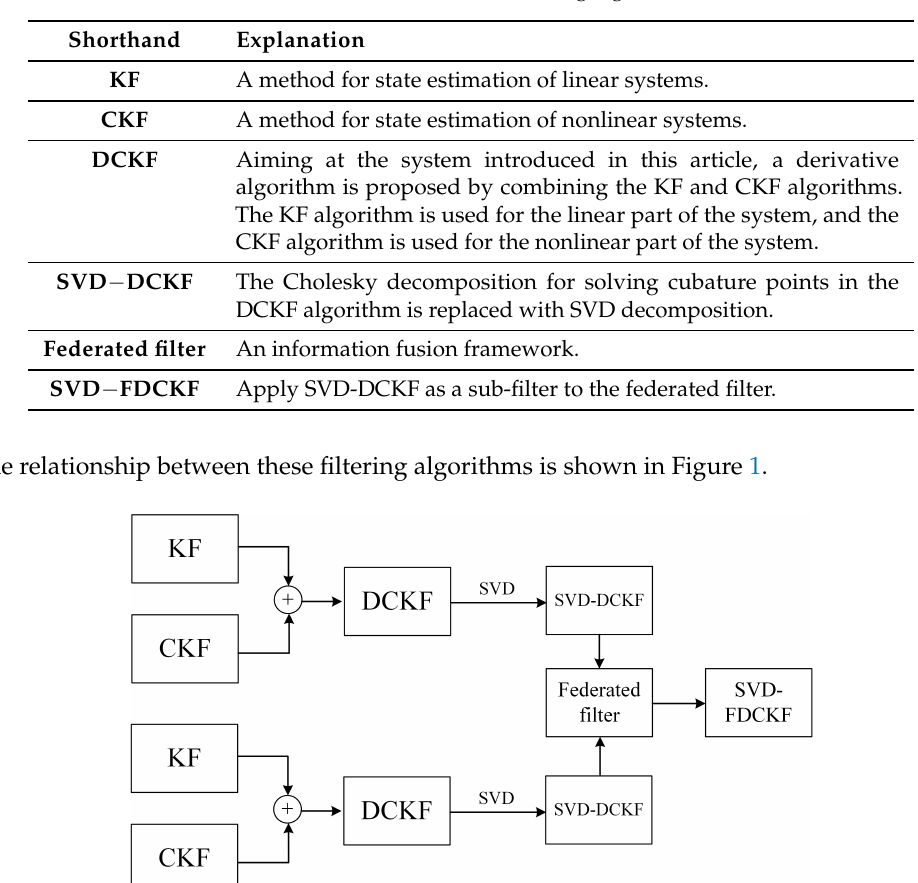
Table 1. Shorthand table of filtering algorithms.